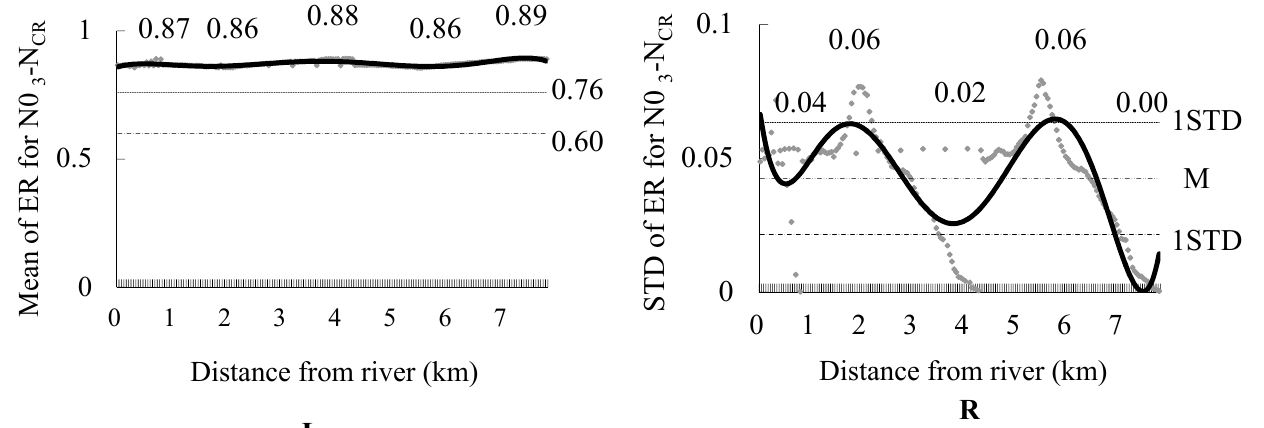
Figure 4. Mean and STD functions of the ERs between TN CR and NO 3 -N (dependent index) and the distance of water channel (independent index) during the gradual buffer extrapolation, based on the water channel as a start line in the Sanhuanpao wetland. The curve on the left ( L ) is the mean of the ERs between TN CR and NO 3 -N CR , the curve on the right ( R ) is the STD of the ERs between TN CR and NO 3 -N CR , and the numbers in the figure are the maximum and minimum values of the fitting functions.